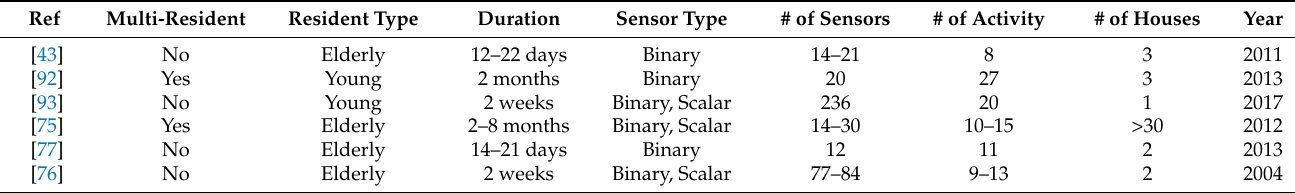
Table 3. Example of real datasets of the